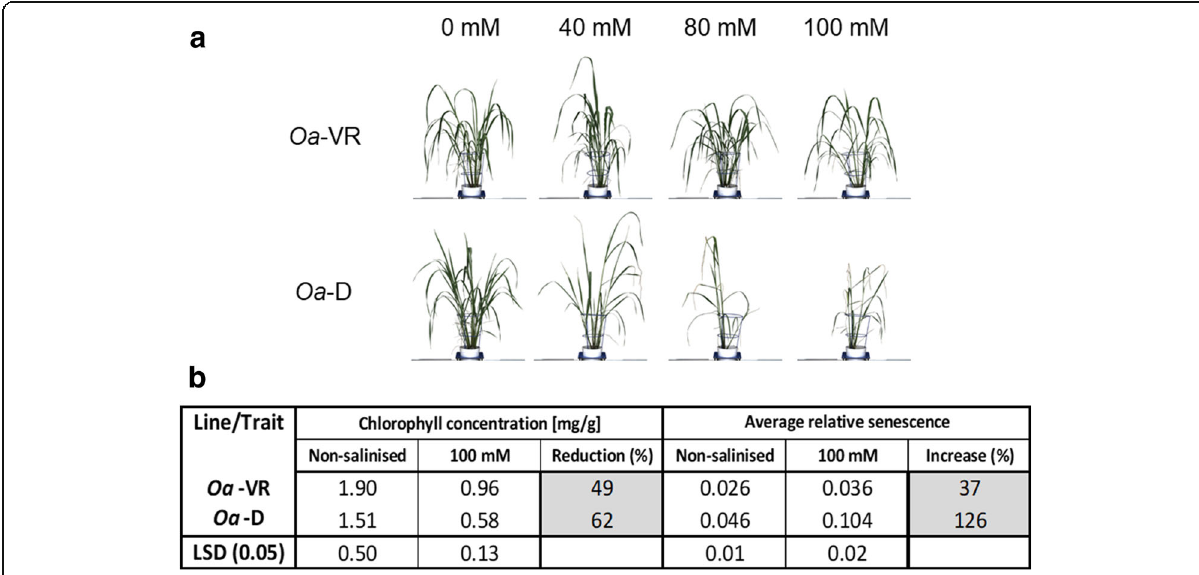
Fig. 4 a Phenotypic changes in response to the different salt treatments 30 days after salting for the salt-tolerant Oa -VR and the salt-sensitive ( Oa -D). b Chlorophyll concentration and average relative senescence under non-salinised (0 mM) and salinised (100 mM NaCl) treatments for both tested